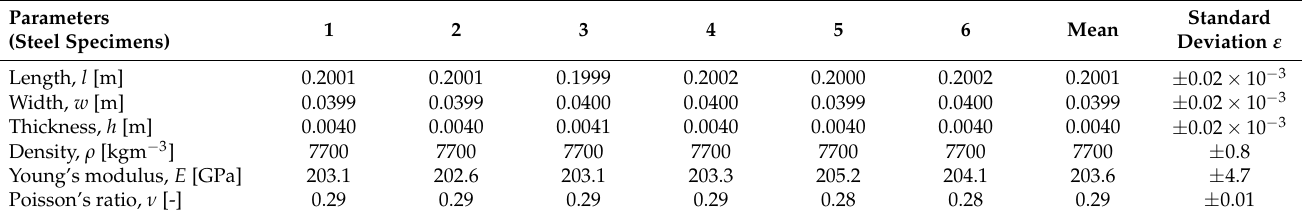
Table 1. The nominal values of the geometrical and material parameters with the averaged deviation ε over six samples. Parameters (Steel Specimens) Length, l